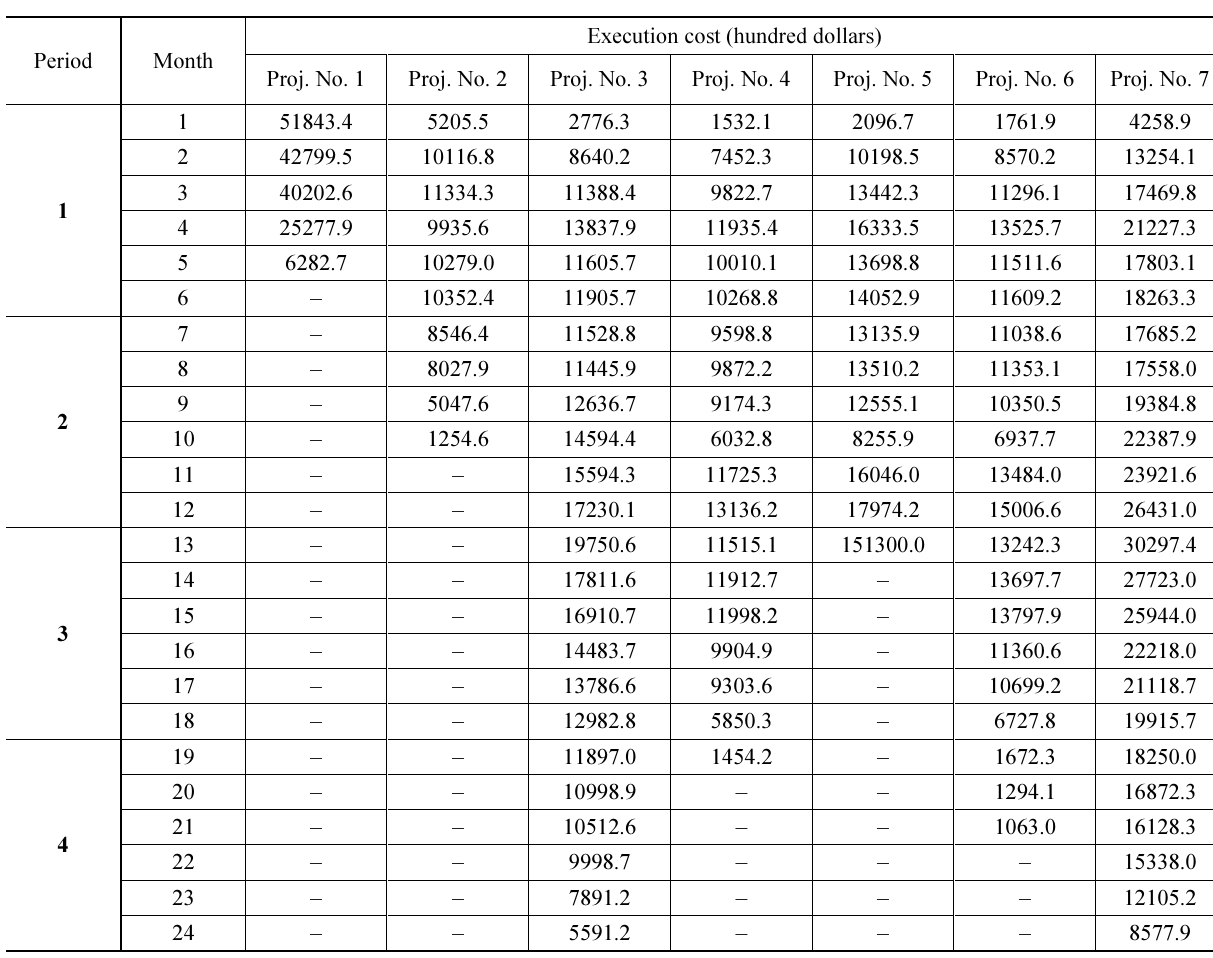
Table 6. Execution cost distribution of projects